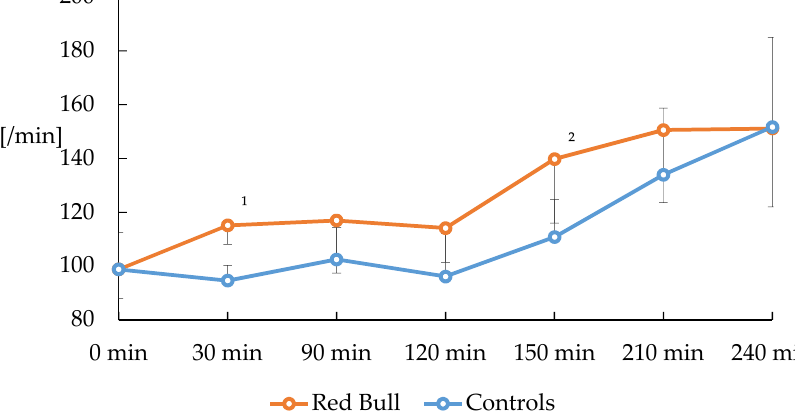
Figure 1. Course of heart rate after consumption of Red Bull or placebo in normoxic and hypoxic piglets ( n = 16). 1 p < 0.01 versus control, 2 p < 0.05 versus control. Normoxia (F i O 2 = 0.21) 0–120 min, Hypoxia (F i O 2 = 0.13) 120–240 min. Piglets ( n = 8) received 10 mL/kg Red Bull at 0 min and 5 mL/kg at 150 min, respectively. Values are mean ± standard deviation.